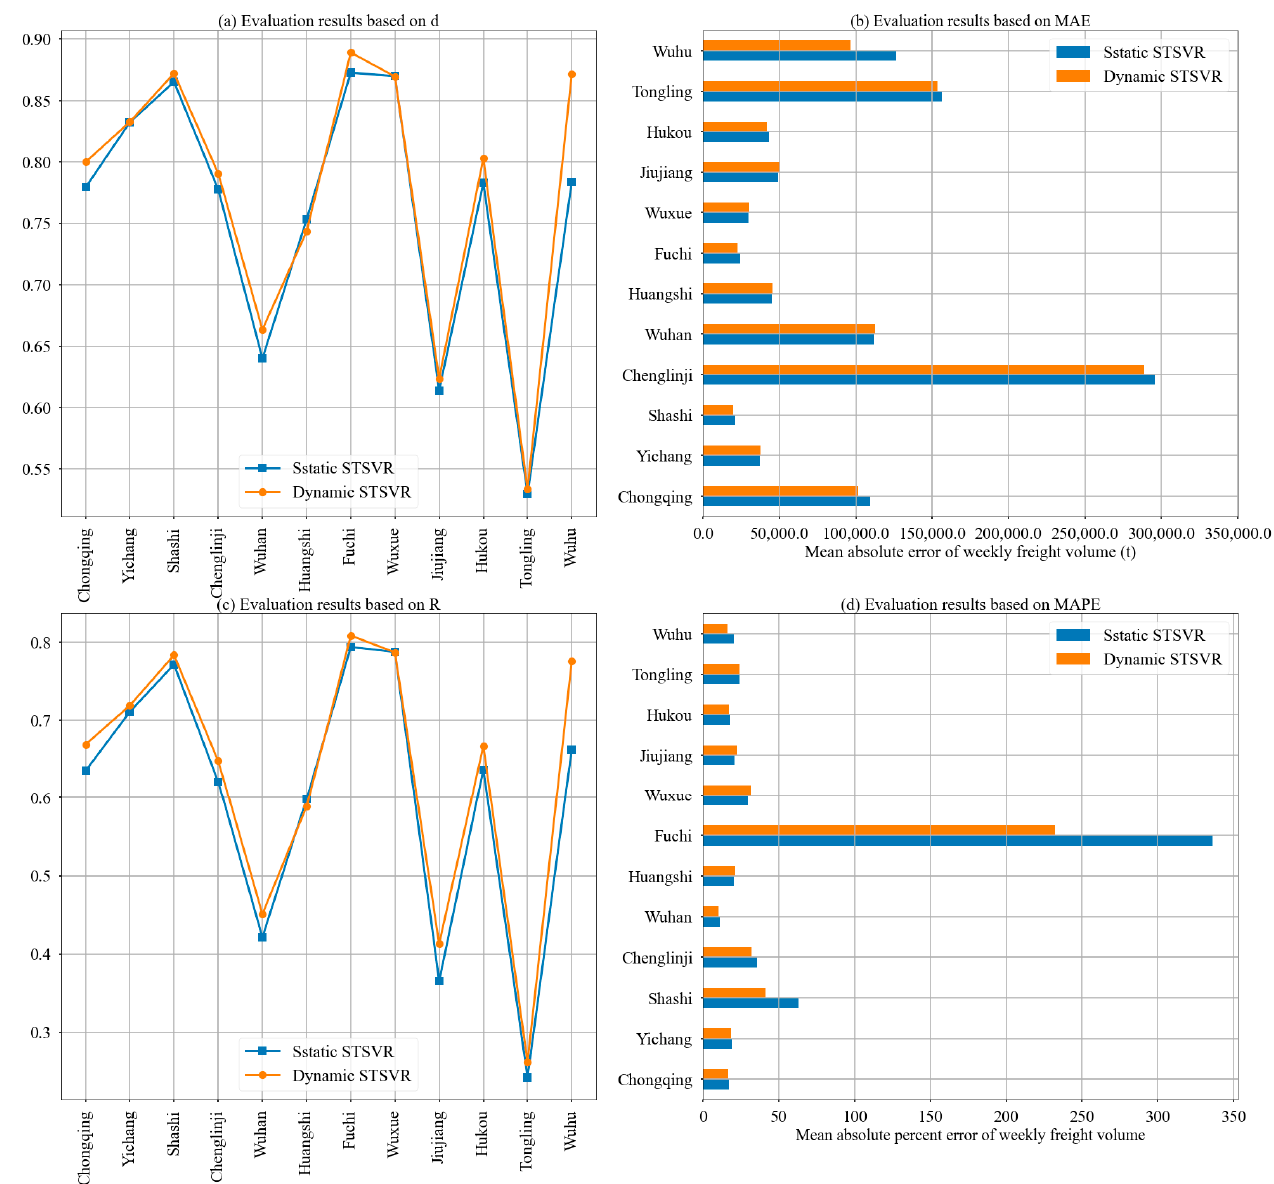
Figure 11. Evaluation results of predictions based on dynamic SVR-GBDT and static STSVR.